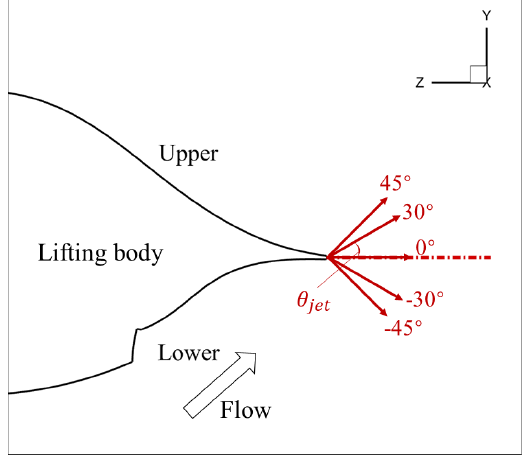
Figure 20. Definition of the blowing direction.